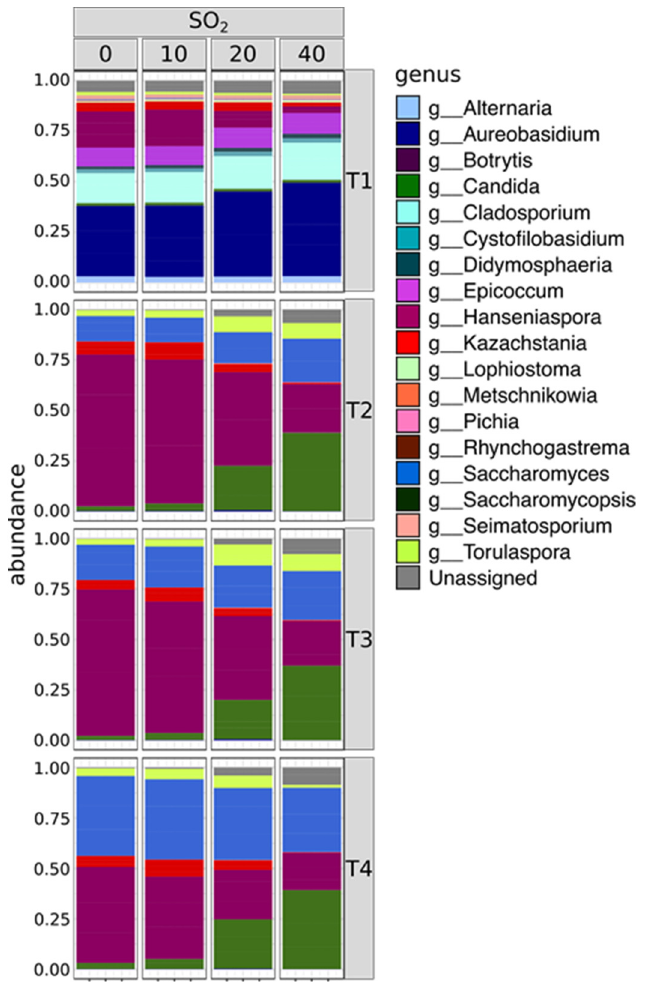
Figure 3. Genus-level meta-barcoding analysis of community response to the SO 2 addition. Vintage 2019 Chardonnay juice was treated with increasing concentrations of total SO 2 (mg/L). Ferment samples were taken at four timepoints (T1, at crush; T2, 10% sugar utilization; T3, 50% sugar utilization; T4, 90% sugar utilization) and subjected to ITS metabarcoding. Only genera that exceeded 0.1% abundance in at least one sample are shown.